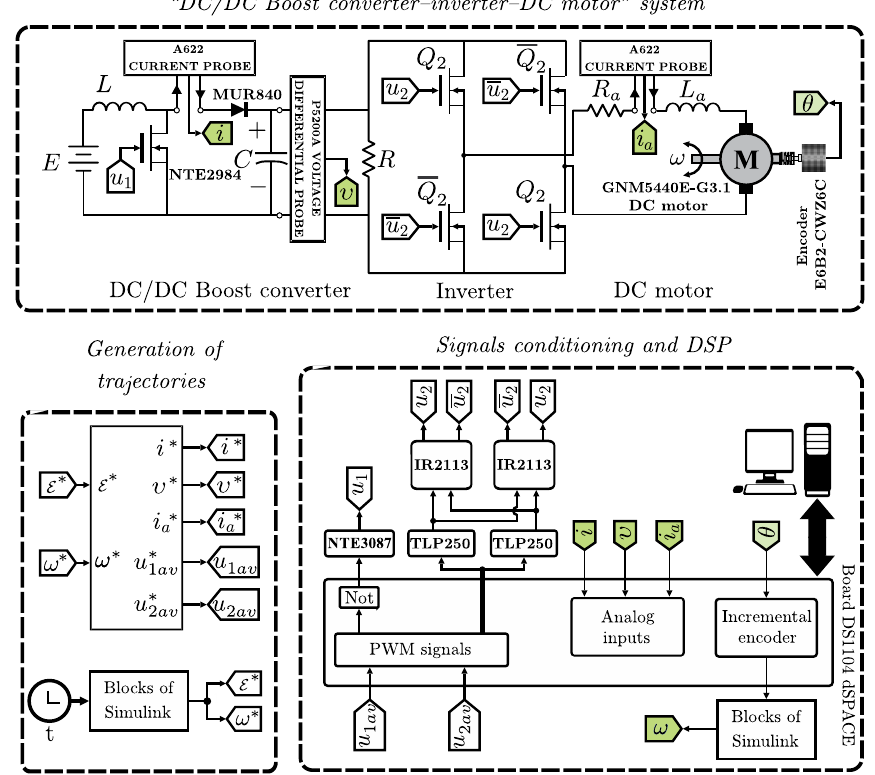
Figure 7. Block diagram of the built experimental